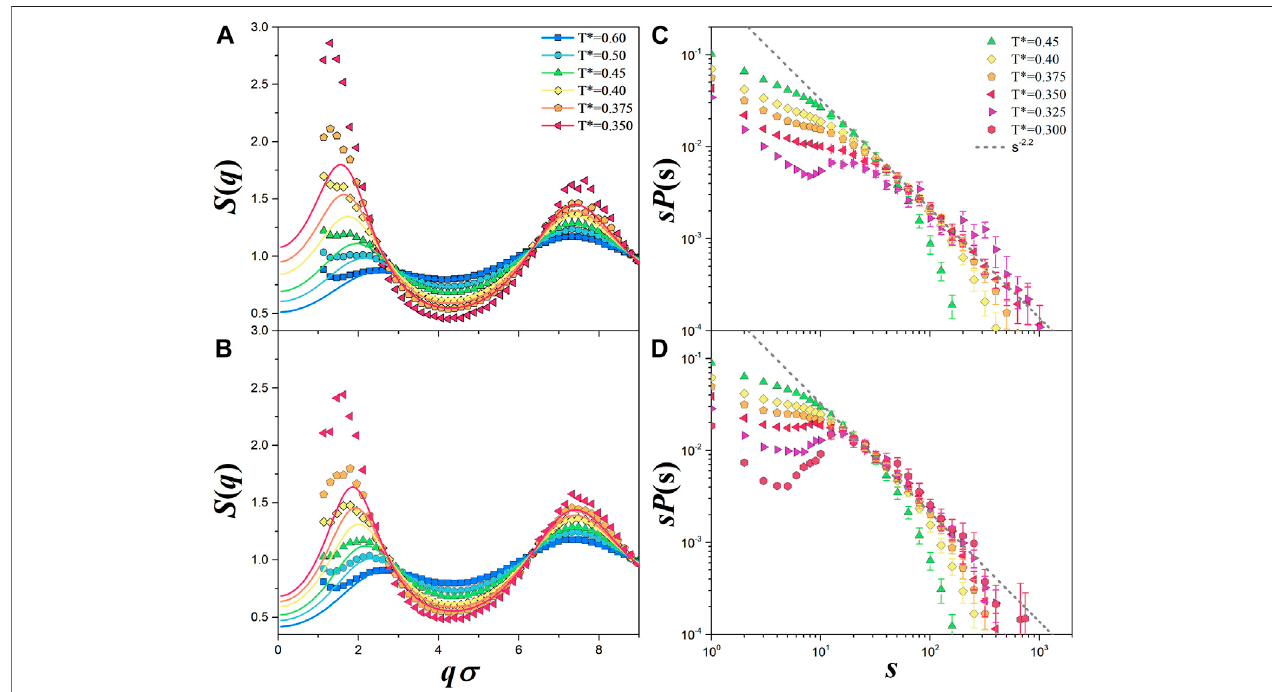
FIGURE2| Structure factorforcompetinginteractionsystemswhoserepulsion strengthis (A) A (cid:2) 0 . 7and (B) A (cid:2) 1 . 0at ϕ (cid:2) 0 . 1anddifferenttemperatures. (C,D) show the corresponding cluster size distributions. Computer simulation results are denoted by symbols, while solid lines are the theoretical solution to the Ornstein- Zernike equation with the Percus-Yevick closure. In (C,D) we also include P ( s ) ∼ s − 2 . 2 (solid line), the limit case for random percolation, see [35].